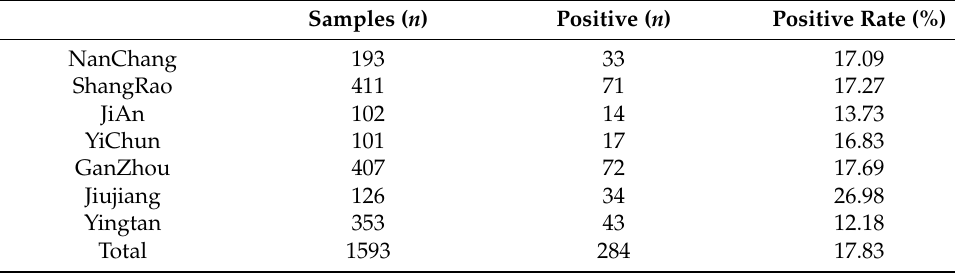
Table 3. Rep antibody detection results by ELISA from 1593 serum